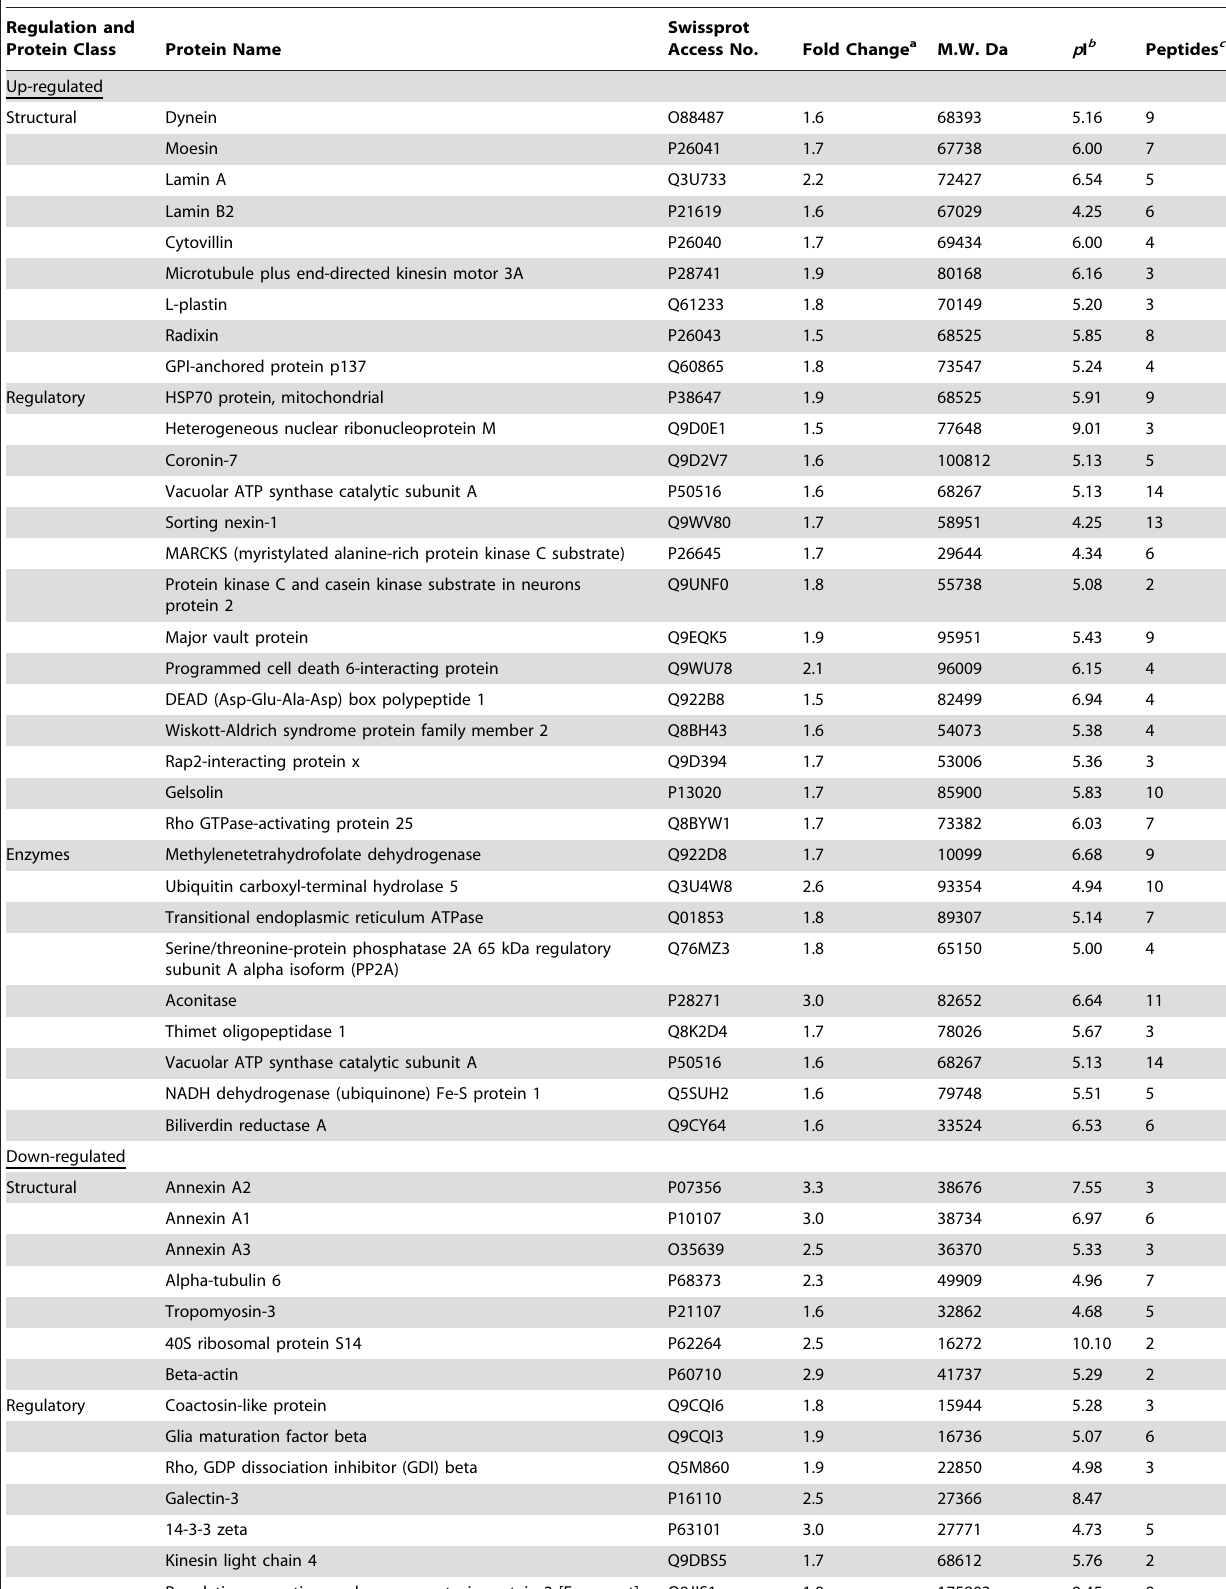
Table 2. Astrocyte effect on the proteome of HIV-1/VSV infected microglia.